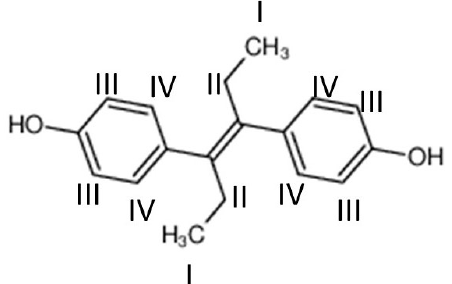
Figure 1. Structure of diethylstilbestrol (DES). Protons studied by 1 H-NMR are labeled.